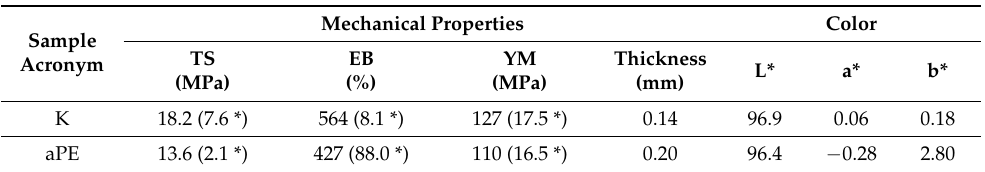
Table 1. The physicochemical properties of pure PE (K) and PE films with an active mixture (aPE): tensile properties and color